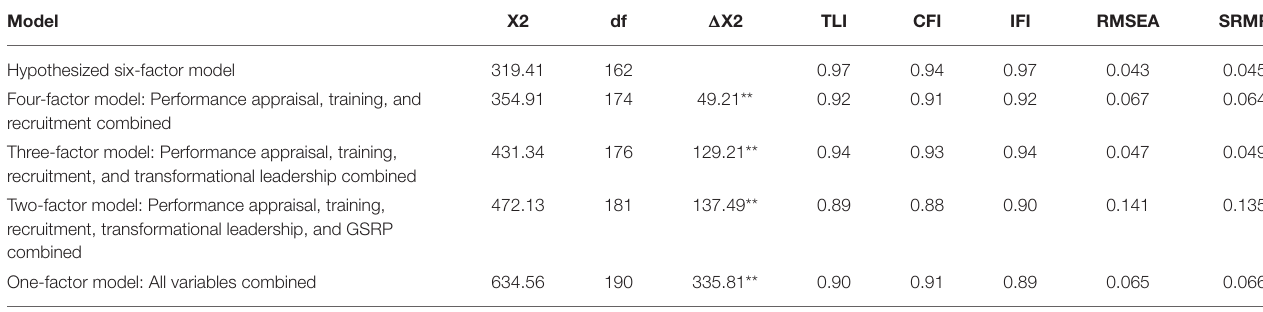
TABLE 1 | Comparison of measurement models.